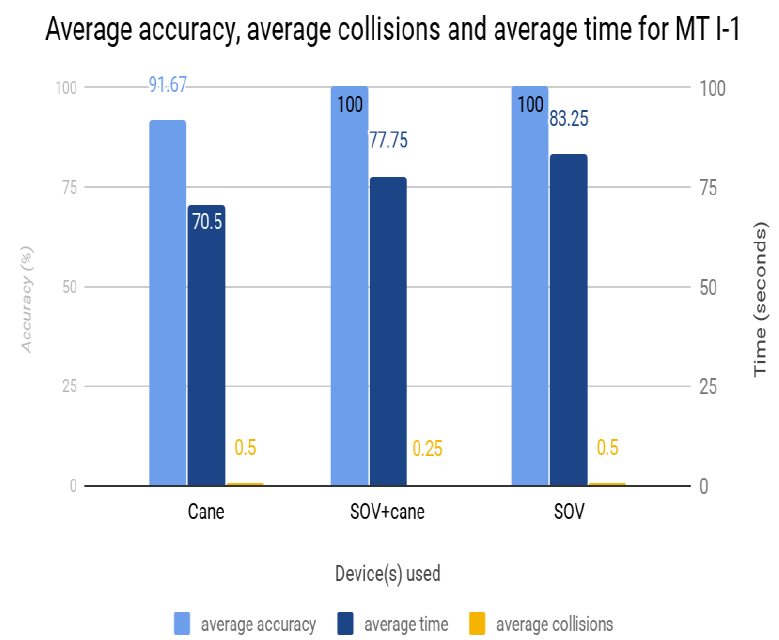
Figure 8. Average accuracy, collisions and completion time over all users in mobility scenario MT I-1 (walking by a wall) when using the SoV system alone, SoV and white cane, white cane alone.